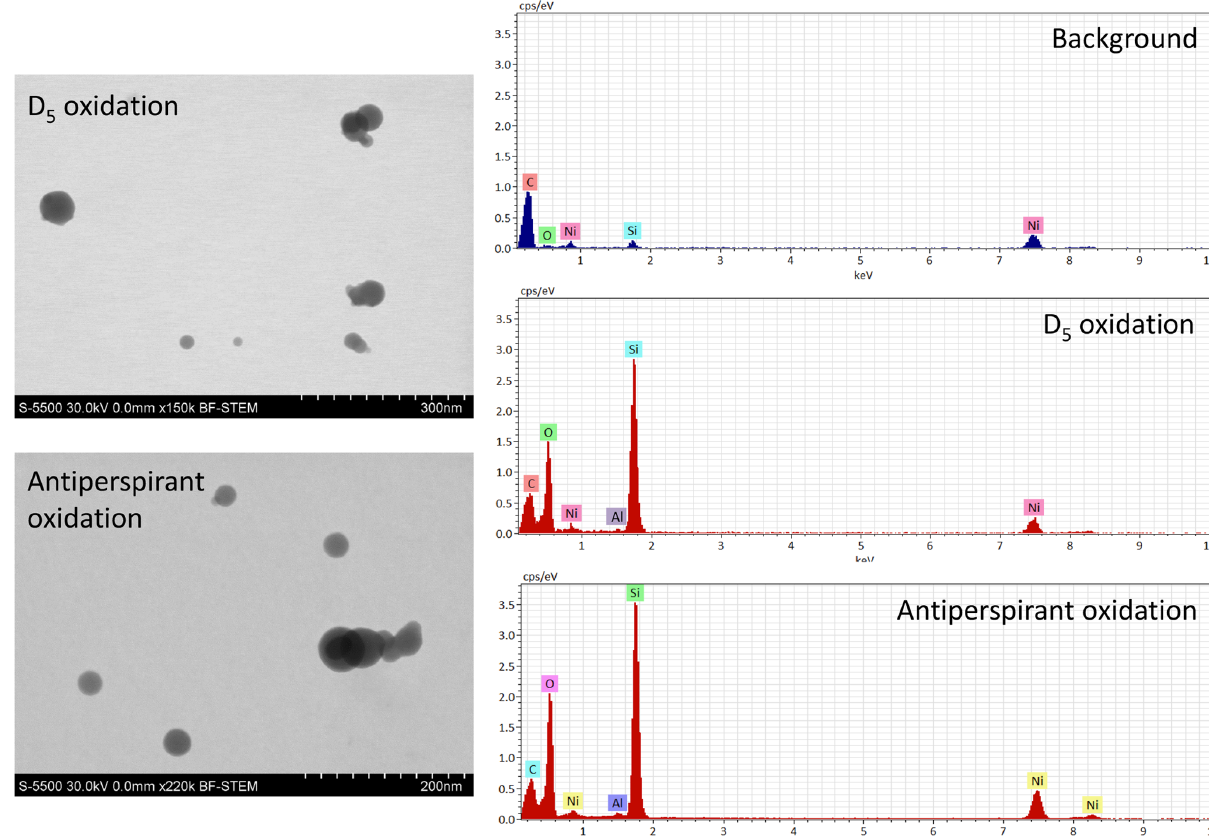
Figure 4. STEM-EDS analysis of D 5 oxidation aerosols and antiperspirant oxidation aerosols obtained from analysis of TPS100